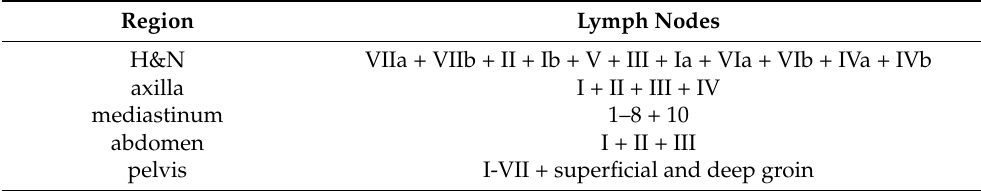
Table 1. Lymph nodes included in the CTV_LN, divided per anatomical